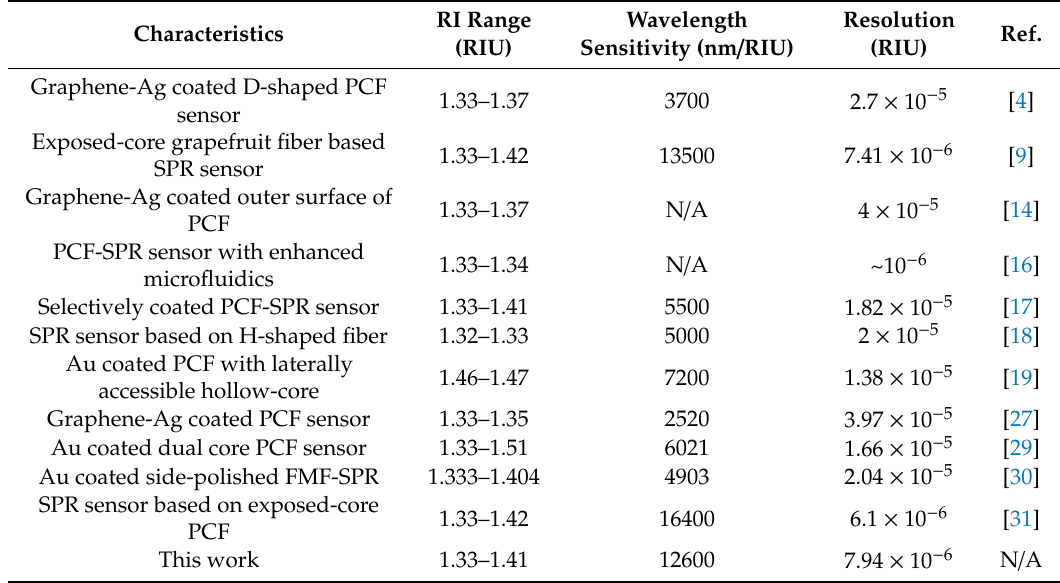
Table 1. Performances of other PCF-SPR sensors.